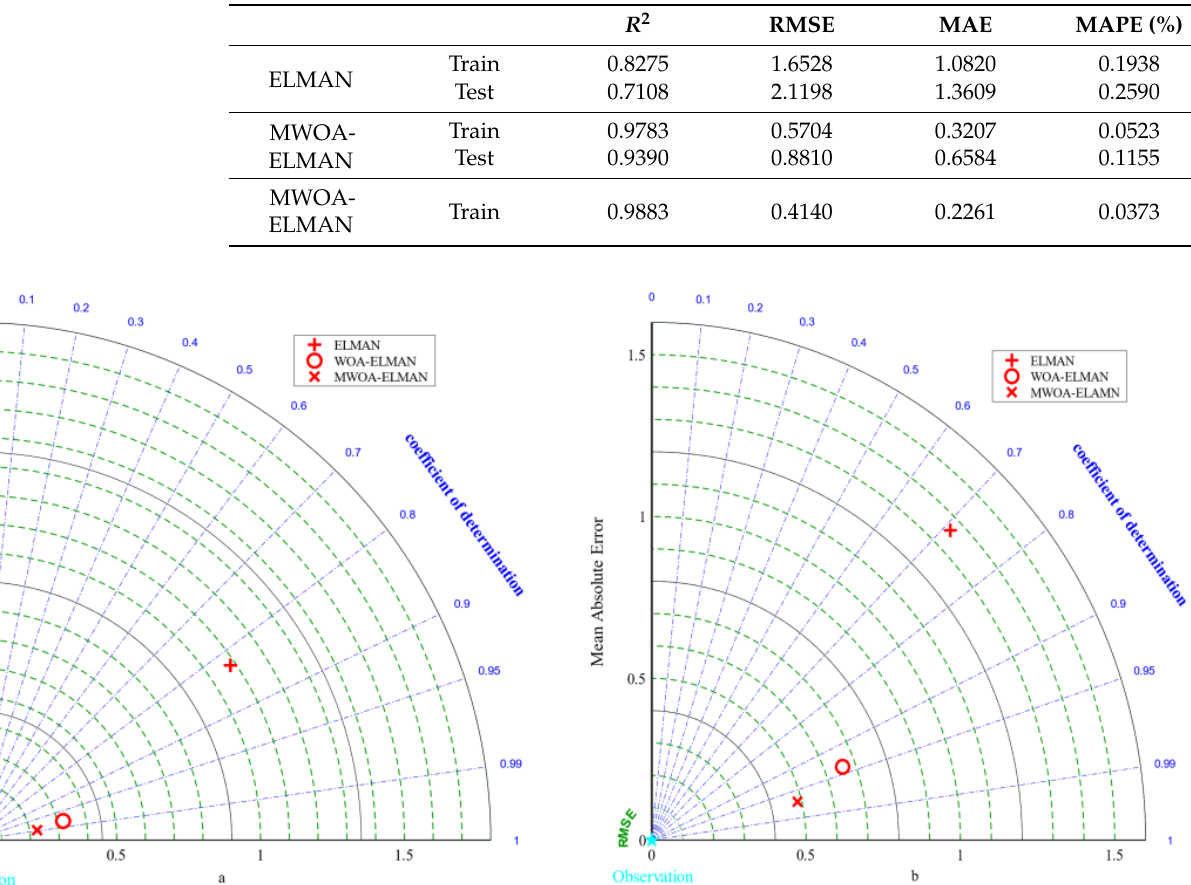
best results. Figure 10 represents the Taylor diagrams for the training and testing sets. From Figure 10, the results of the MWOA-ELMAN model were closest to the optimal reference point, indicating that the algorithm is effective in optimizing the weights and improving the model’s prediction accuracy. Table 7. Average of evaluation indicators for three ELMAN models.